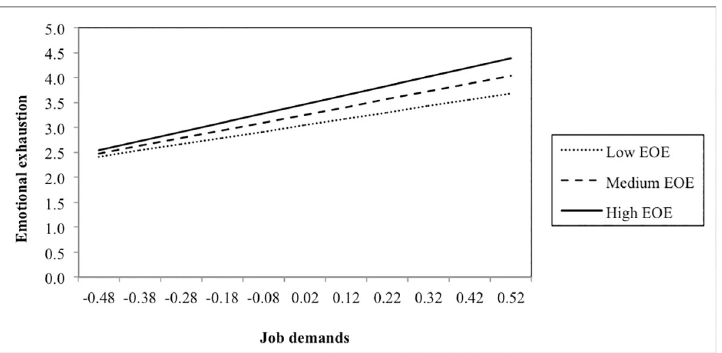
Fig 2. Interaction between job demands and ease of excitation (EOE) in predicting emotional